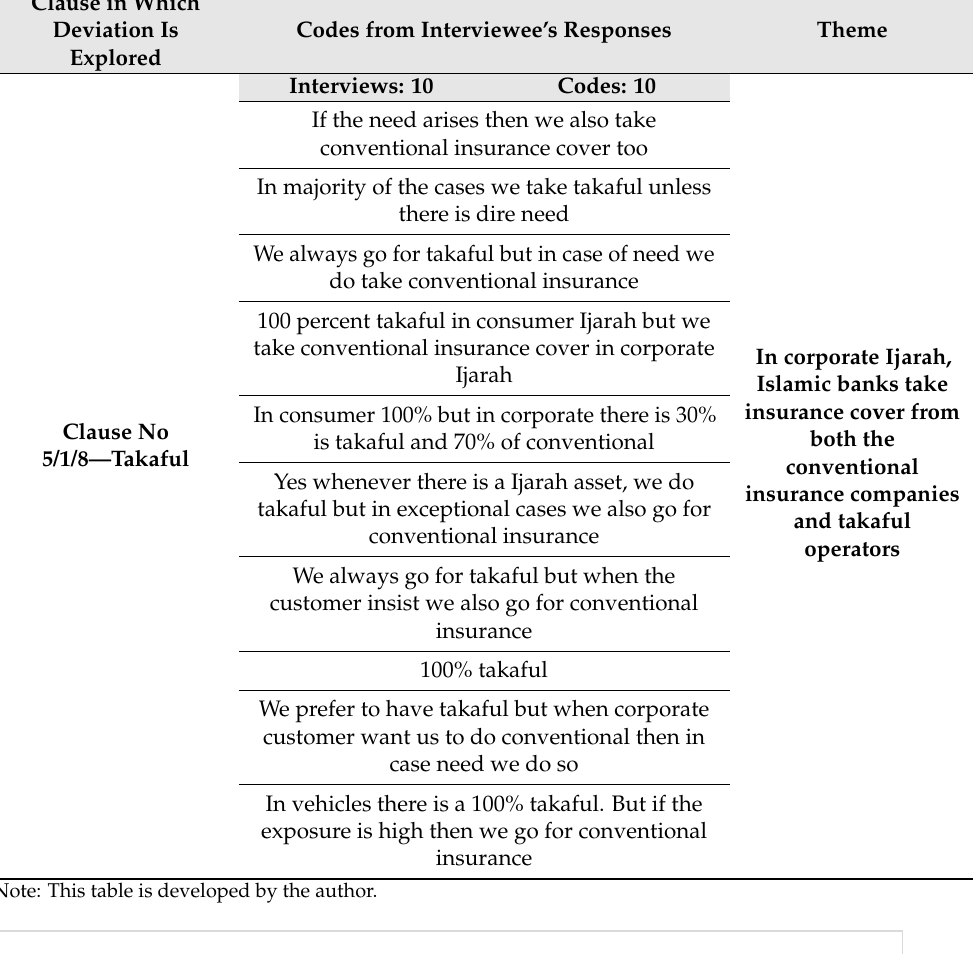
Table A5. Clause 5/1/8—takaful.